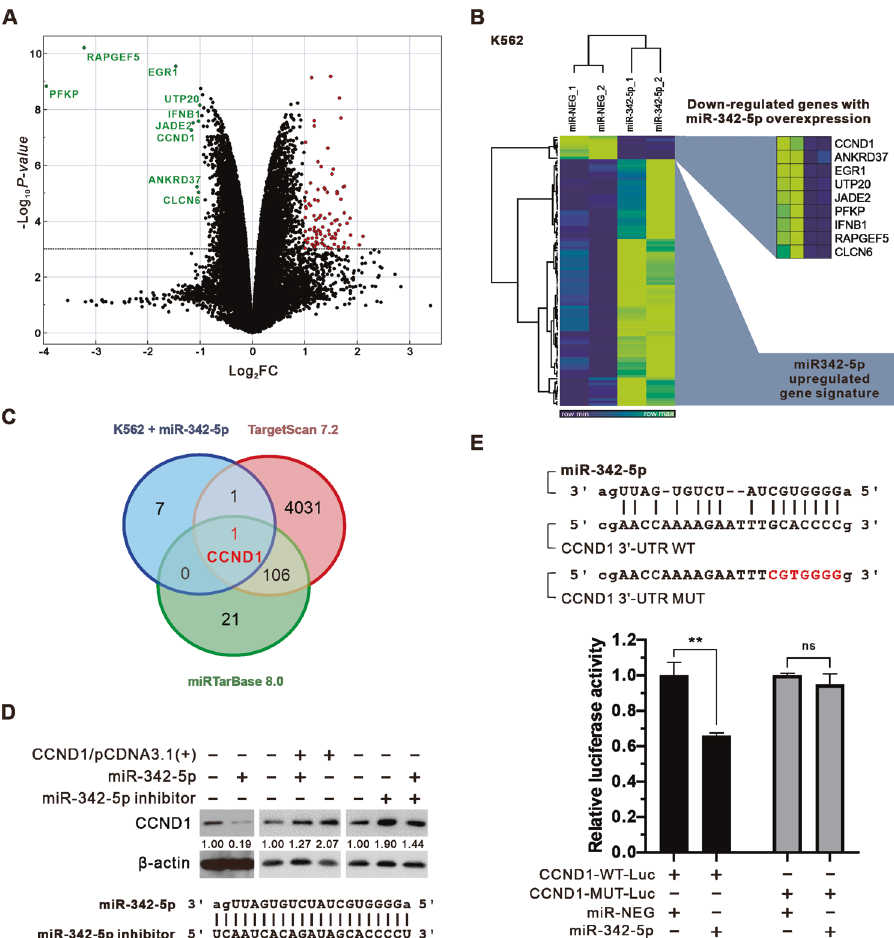
Fig. 3 Combining experimental validation and prediction of miRNA target database with microarray analysis to fi nd CCND1 as the target of miR-342-5p. A Volcano plot showing the distribution of differentially expressed genes with miR-342-5p expression. The red dots represent signi fi cantly upregulated genes, and the green represents signi fi cantly downregulated genes. Filtering criteria: |Log 2 FC | ≧ 1, − Log 10 p -value >3. B Heat map presents the relative expression and hierarchical clustering of differentially expressed genes with or without miR-342-5p expression. C Venn diagram presents the results of the intersection of K562 expressing miR-342-5p downregulated gene (blue circle), TargetScan predicting miR-342-5p target gene (red circle), and miRTarBase experiment validated miR-342-5p target gene (green circle). D Western blot to con fi rm the expression of CCND1 affected by miR-342-5p (20 nM) or miR-NEG (20 nM) transfection combined with CCND1/ pCDNA3.1( + )(3 μ g) or miR-342-5p inhibitor (50 nM). The sequence of the utilized miR-342-5p inhibitor is shown below. E The miRANDA- predicted miR-342-5P sequence is aligned with the CCND1 3 ′ -UTR WT target sequence. Sequences with manipulated mutations in the CCND1 3 ′ -UTR MUT are shown in red. Luciferase activity assay shows the relative intensity of luminescence generated by CCND1-WT-Luc or